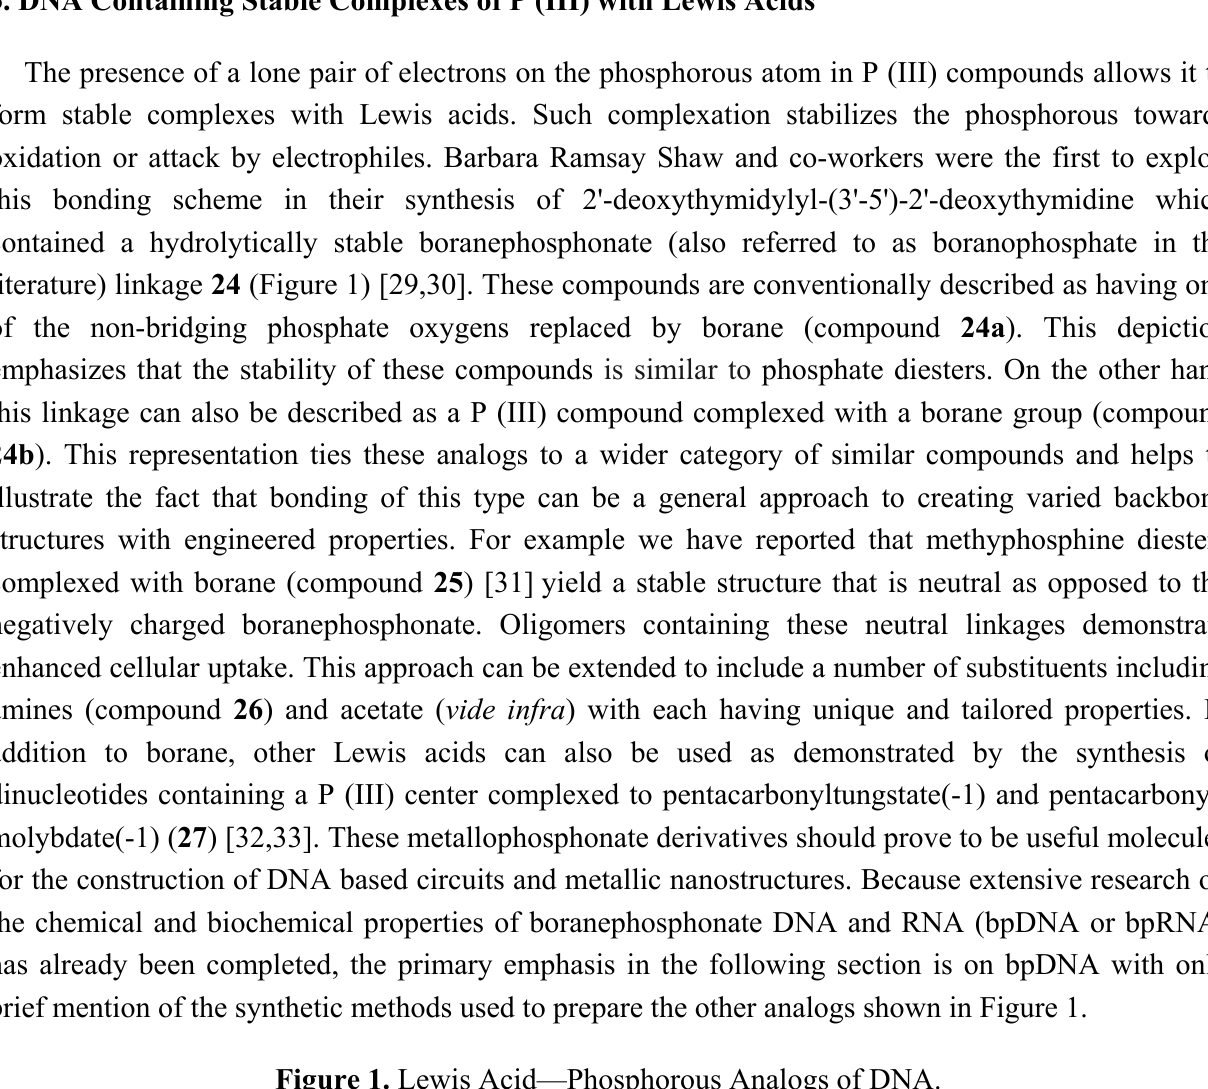
Figure 1. Lewis Acid—Phosphorous Analogs of